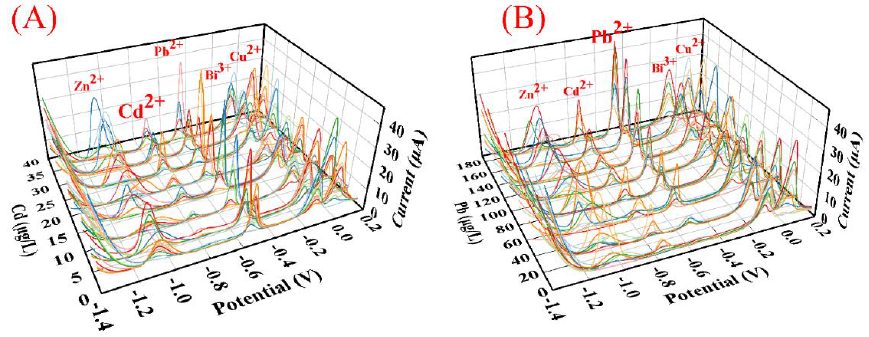
Figure 4. The SWASV curves of 64 experiments sorted by Cd 2+ ( A ) and Pb 2+ ( B ) concentration.